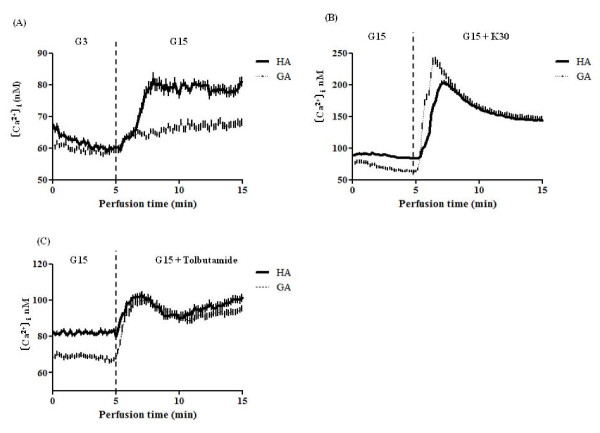
Changes in intracellular free calcium concentration ([Ca2+]i). (A) Effect of GA on ([Ca2+]i). [Ca2+]i was measured under the G3 condition during the first 5 min, then under the G15 condition for the next 10 min, in the presence of 0.1 mg/mL HA (thick line) or GA (thin line). Data represent the mean plus SEM of 2 separate experiments, each with n = 4-10.. (B, C) [Ca2+]i was measured in the presence of HA (thick line) or GA (thin line) under the G15 condition. Islet cells were incubated for the first 5 min, and then in the presence of 30 mM K+ (B) or 100 μM Tolb (C) for the next 10 min, in the presence of 0.1 mg/mL HA (solid) or GA (dotted). Data represent the mean plus SEM of 2 separate experiments, each with n = 4-10. ss; statistically significant.